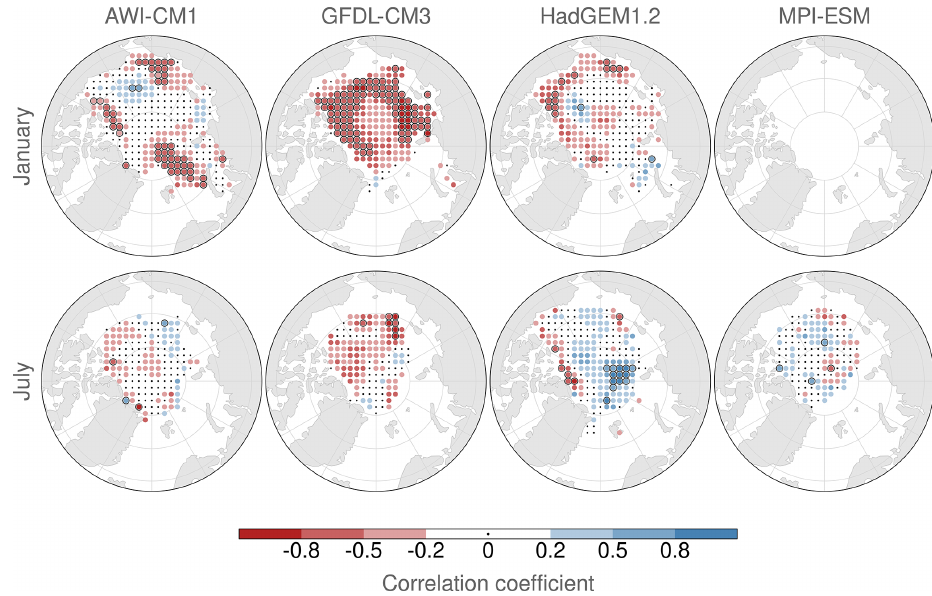
Figure 10. Correlation of target position normalized uncertainty at t = 45d and initial sea ice thickness for each initial position for January (top) and July (bottom) initializations. Black dots indicate locations with correlation weaker than ± 0 . 02. Colored dots encompassed by a black circle denote a p value smaller than 0 . 05. The different initializations, at least eight, serve as the sample per target